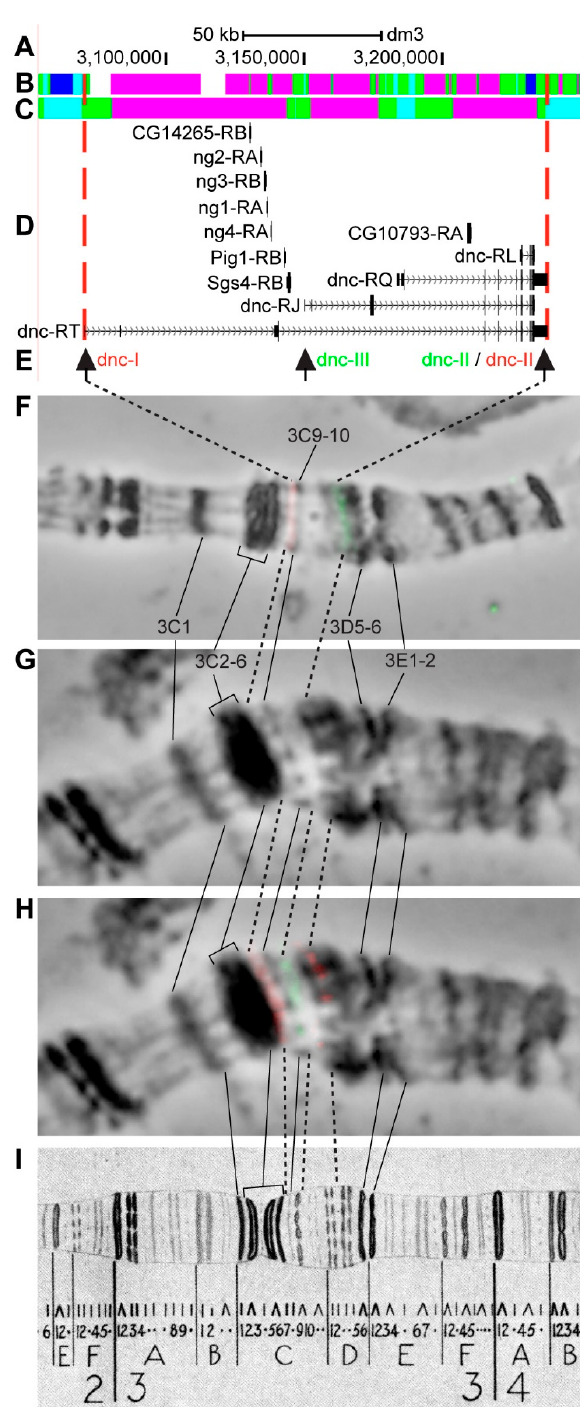
Figure 13. Localization of the dnc gene in the 3CD region (on the molecular map the gene is bound by red dotted lines). ( A ) the scale (kb) and genomic coordinates (bp); ( B ) the four chromatin-state model [39]; ( C ) the chromatin condensation level model [32]; ( D ) genes location (arrow lines show the gene orientation and black bars indicate the location of gene exons); ( E ) probes location; ( F ) combined FISH signals on the stretched chromosome preparation; ( G ) phase-contrast micrograph of the region; ( H ) combined FISH signals; and, ( I ) C. Bridges’ chromosome map